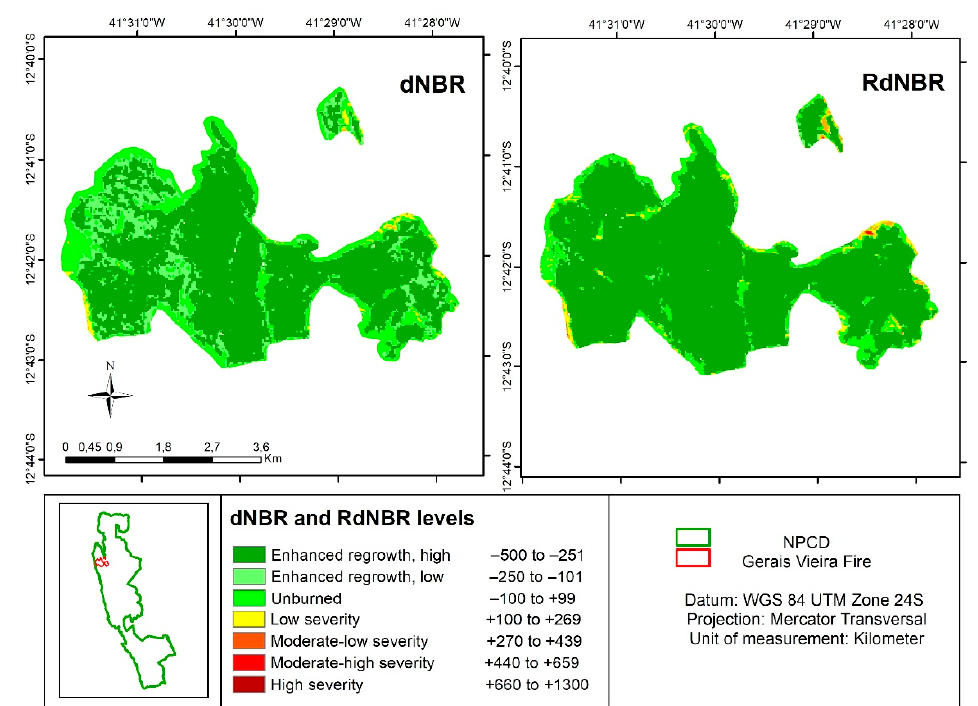
Figure 7. Regrowth of the burnt area identified by the dNBR and RdNBR indices for the Gerais do Vieira fire (classification by Key and Benson [10]).